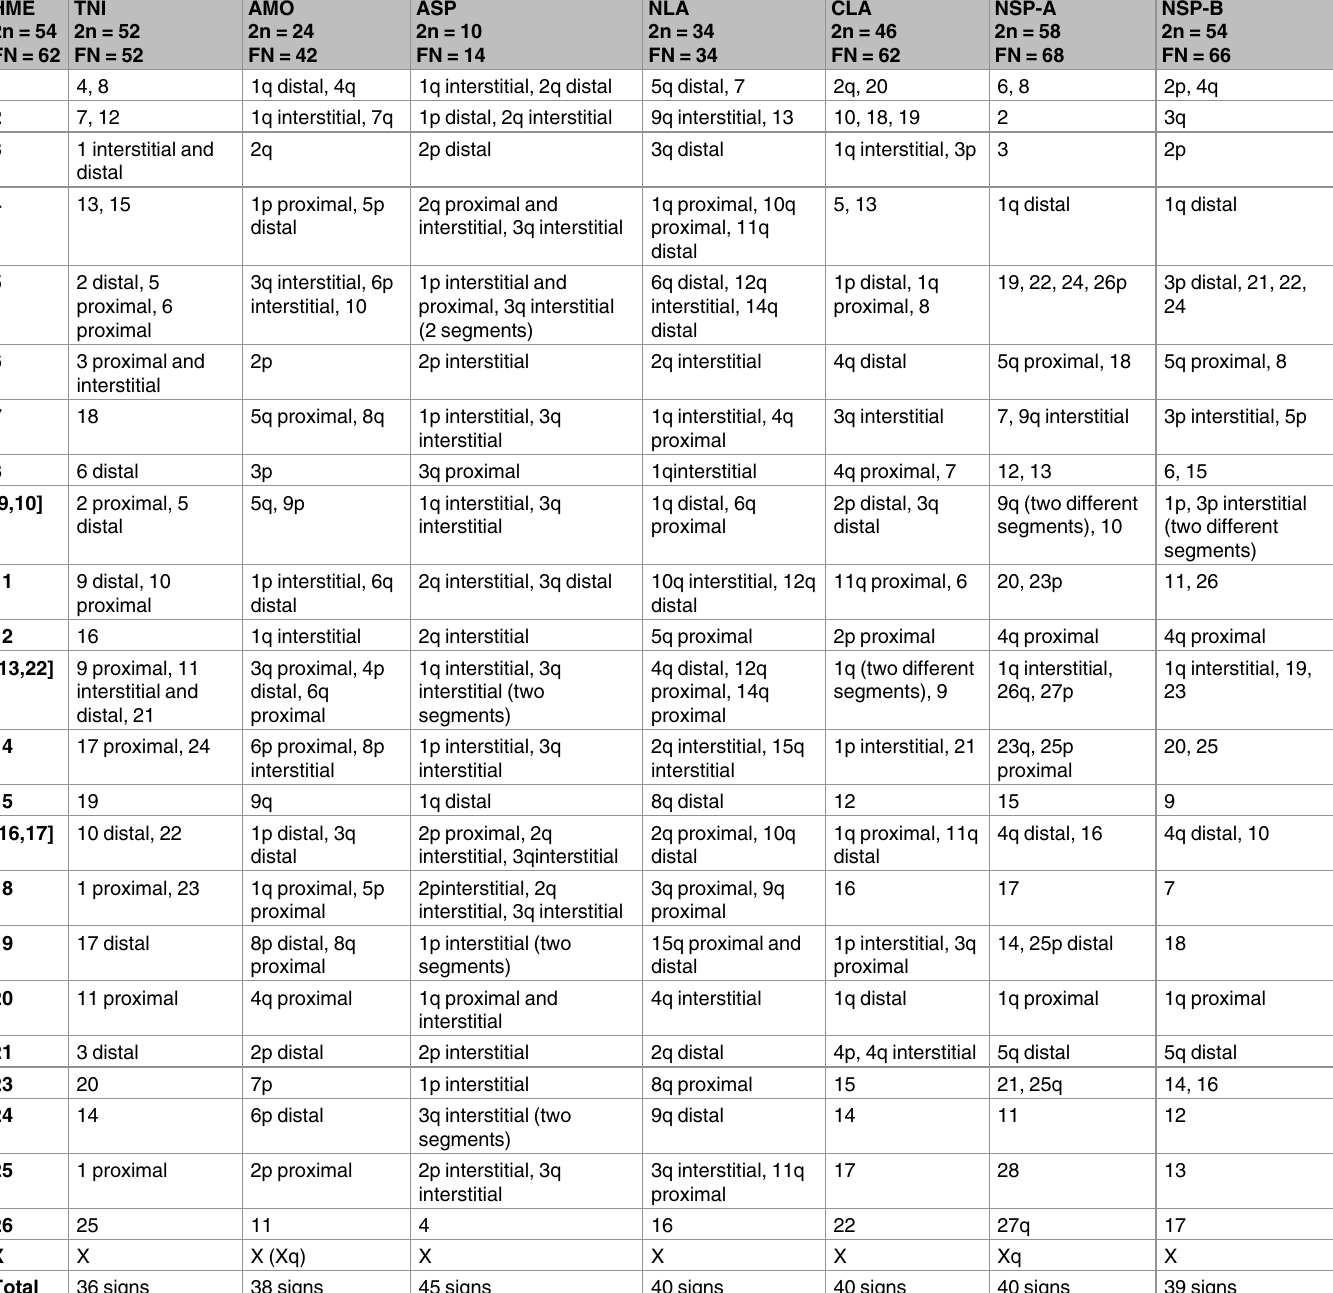
Table 2. Chromosomal homology among Hylaeamysmegacephalus (HME), Cerradomys langguthi (CLA) [20], Thaptomys nigrita (TNI), Akodon montensis (AMO) [23], Akodon sp. (ASP), Necromyslasiurus (NLA) [22], Neacomys sp. A (NSP-A) and Neacomys sp. B